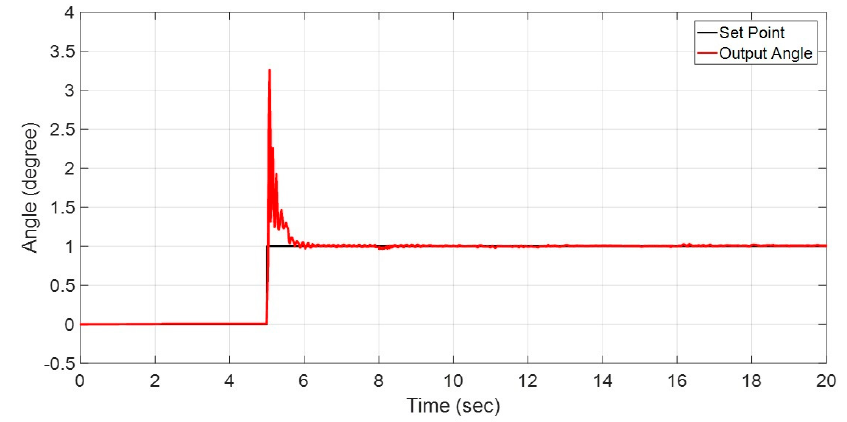
Figure 9. Step response of BLDC Motor using Proportional Integral Derivative.